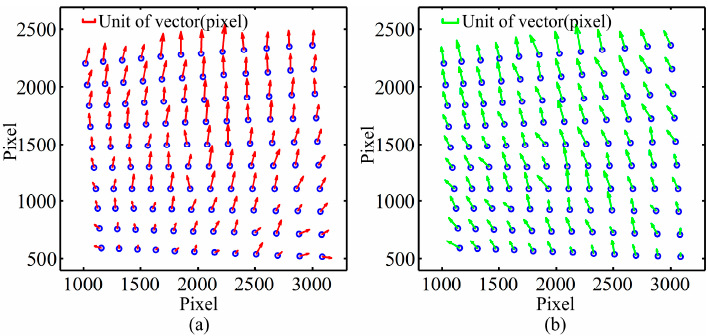
Figure 4. The distance s between different projection color circles: ( a ) the relative distances from the red projection circles to the blue ones; ( b ) the relative distances from the green projection circles to the blue ones. Furthermore, the calibration board is moved to another position by a one-dimensional (1D) translation stage. The distance between the two positions is 50 mm. The identical analysis is repeated in the new position, and the magnitudes of all vectors in the two positions are shown in Figure 5. Data on the left of the imaginary line belong to the first position, while data on the right belong to the second position. In the first position, the mean and standard deviation of the R-B